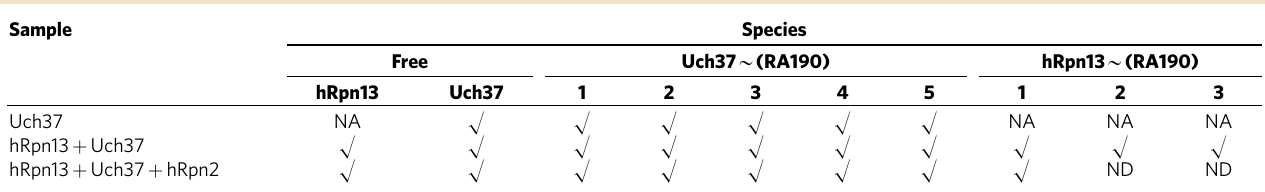
NA, not applicable; ND, not detected. Table summarizing the species detected by mass spectrometry for the indicated samples; 2 m M Uch37, equimolar mixture of 2 m M hRpn13 and Uch37 or equimolar mixture of 2 m M hRpn13, Uch37, and hRpn2wereincubated with25-foldmolarexcess RA190 for2h at 4 (cid:2) Cand the samplessubjected toLC-MSanalysis.Detected Rpn13 orUch37 speciesareindicatedbya check mark,withthe numerical indicator over the column representing numbers of RA190 molecules conjugated based on molecular